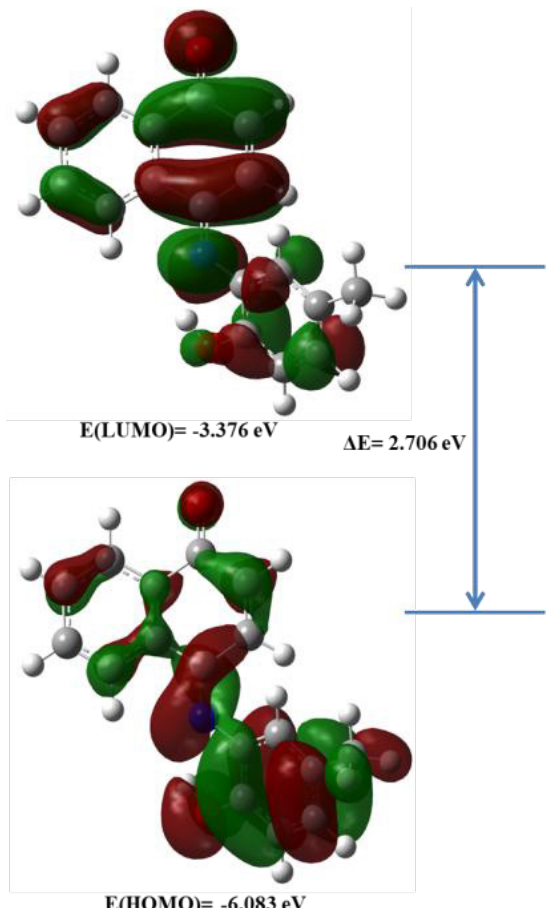
Figure 7: Energy levels and localization distribution of HOMO and LUMO molecular orbitals throughout the PINQ molecule as the representatives of frontiers.